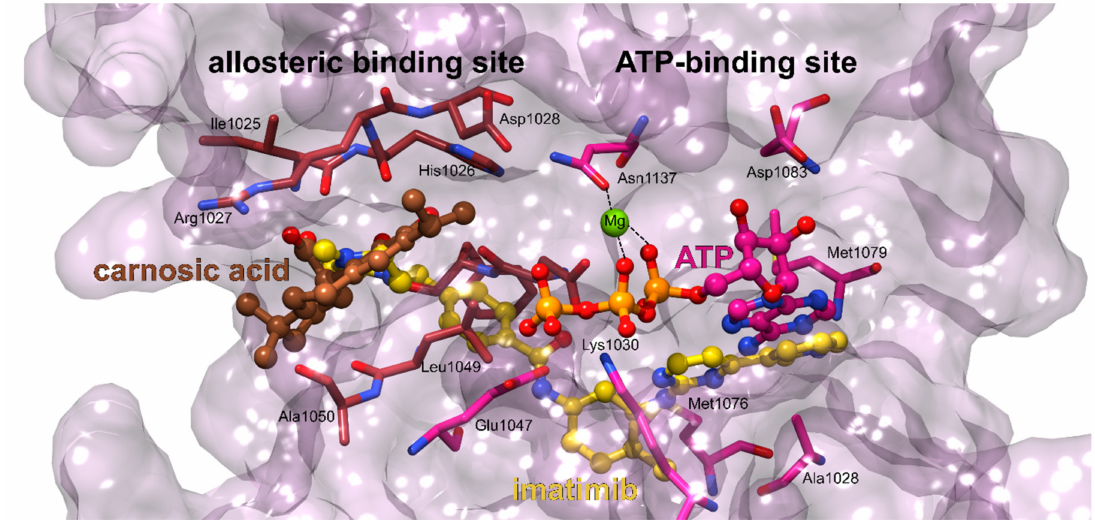
Figure 9. VEGFR2 binding sites. The VEGFR2 enzyme is presented with pink surface; the amino acid residues of the adenosine binding site are shown in pink sticks and of the lipophilic allosteric binding site in brown sticks. The docked carnosic acid located in the allosteric site displayed in brown balls and sticks and the ATP molecule in pink balls and sticks. The typical type II inhibitor imatimib, binding to both sites concurrently is depicted in yellow